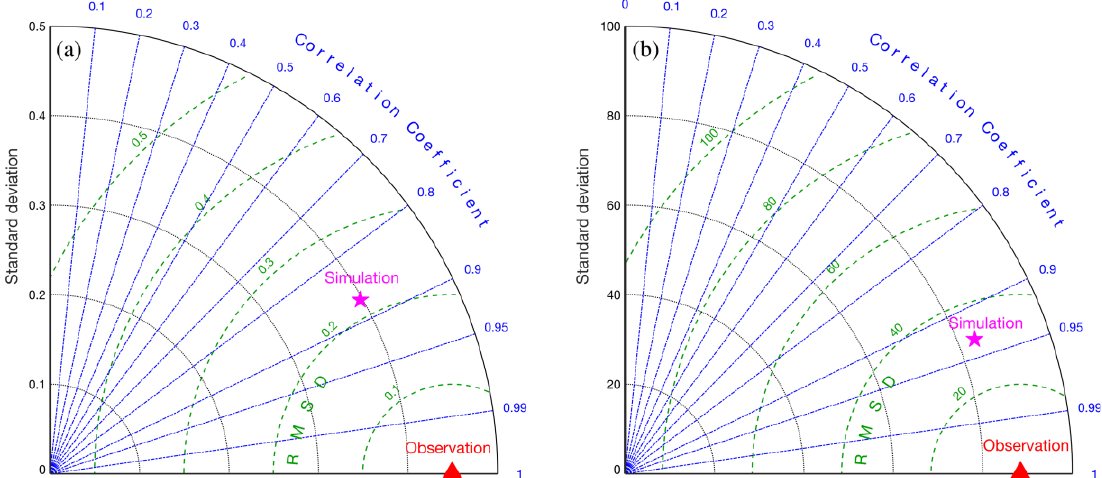
Figure 4. Taylor diagrams for the validation of current magnitude ( a ) and direction ( b ). Note: the radial distance from the origin is proportional to the standard deviation of a pattern; the centered root-mean-square difference between the modeled and observed field is proportional to their distance apart (in the same units as the standard deviation); while the correlation between the two fields is given by the azimuthal position of the modeled field.